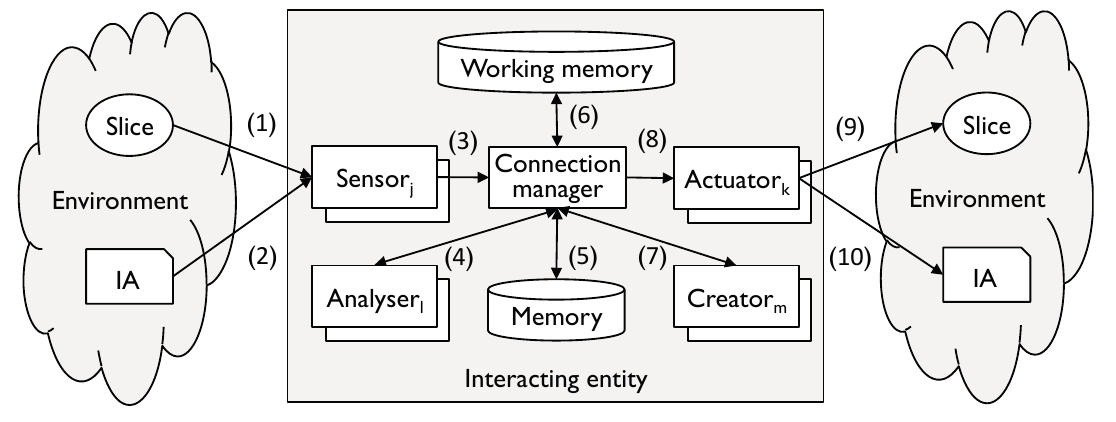
Figure 3. A generic IE in the context of Virtual Connection Models